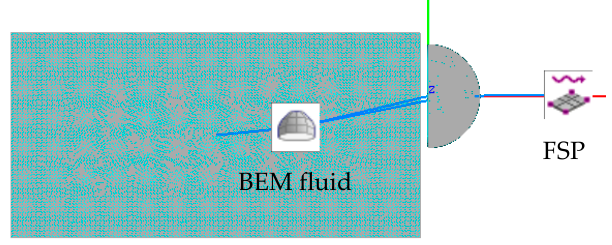
Figure 11. The FM-BEM model of the side mirror and the panel.